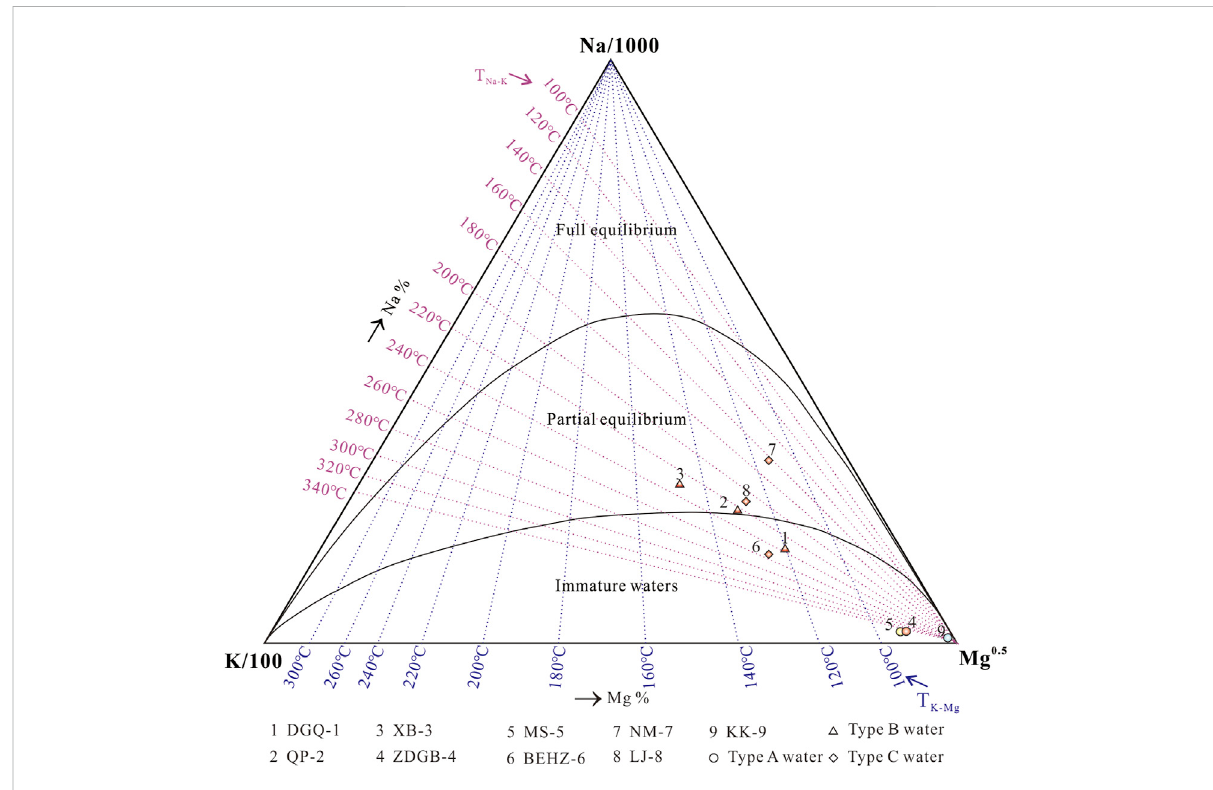
FIGURE 6 Giggenbach Na – K – Mg ternary diagram of spring water samples from the KKF. The legend is the same as in Figure